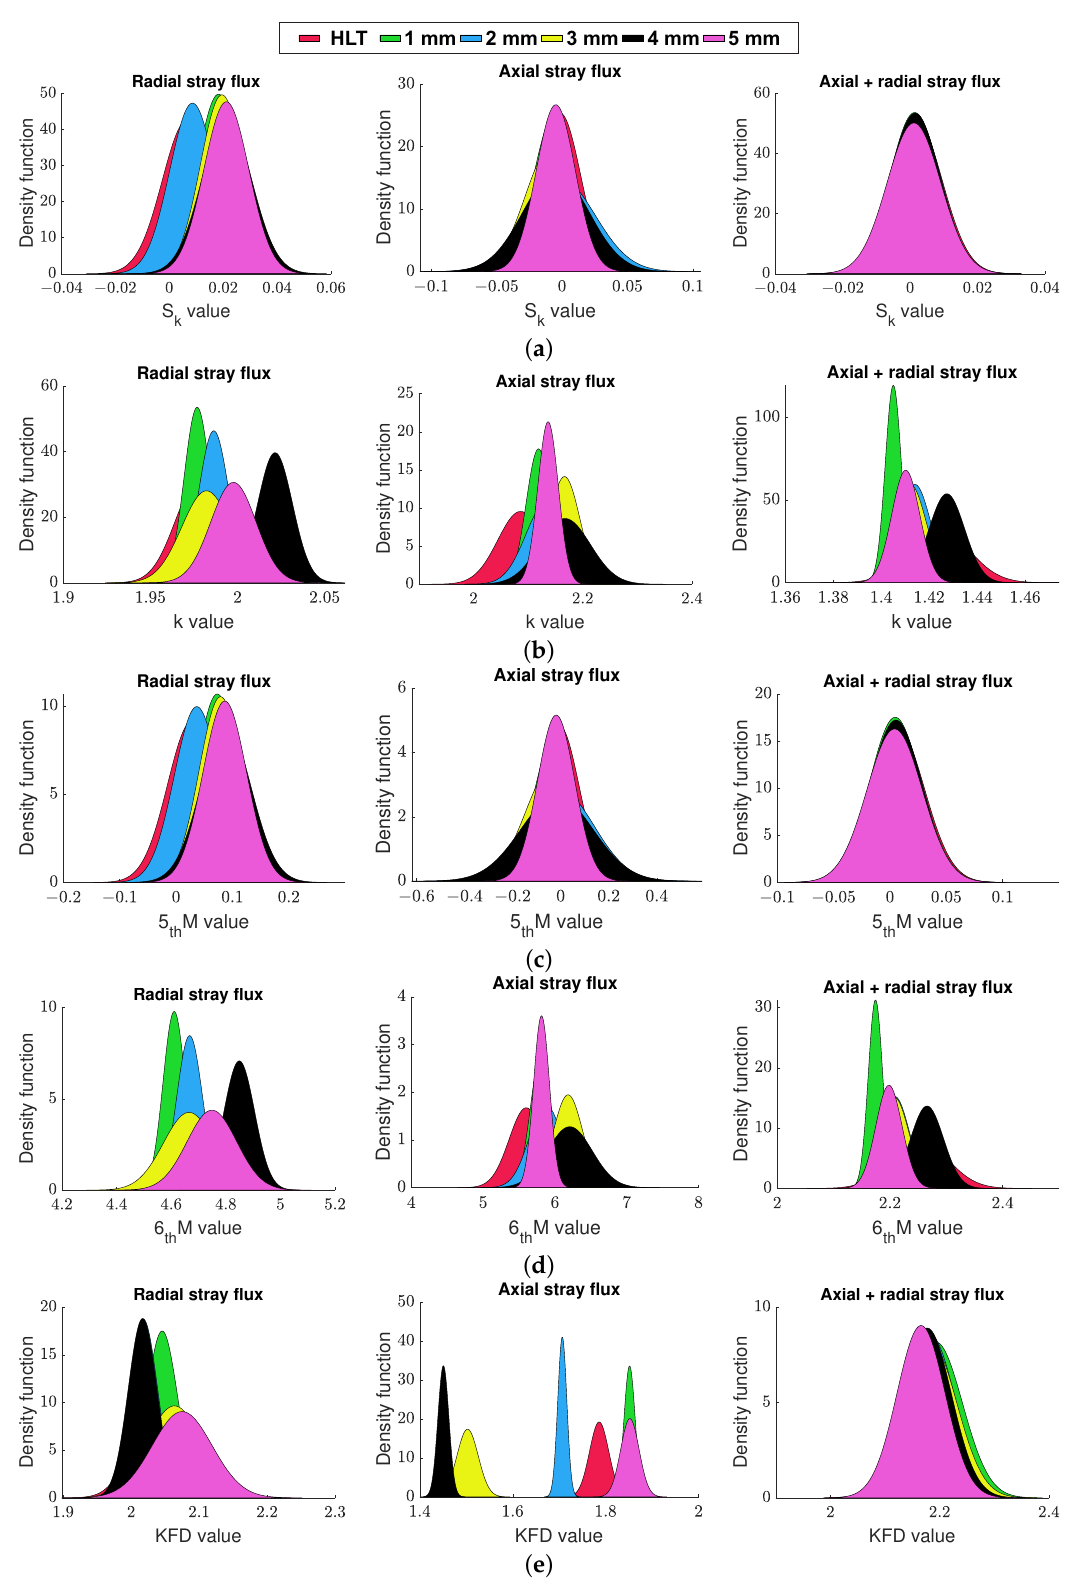
Figure 9. Normalized density functions defining detectability zones obtained by the different TF values from the different stray flux components using: ( a ) S k value. ( b ) k value. ( c ) 5 th M value. ( d ) 6 th M value. ( e ) KFD